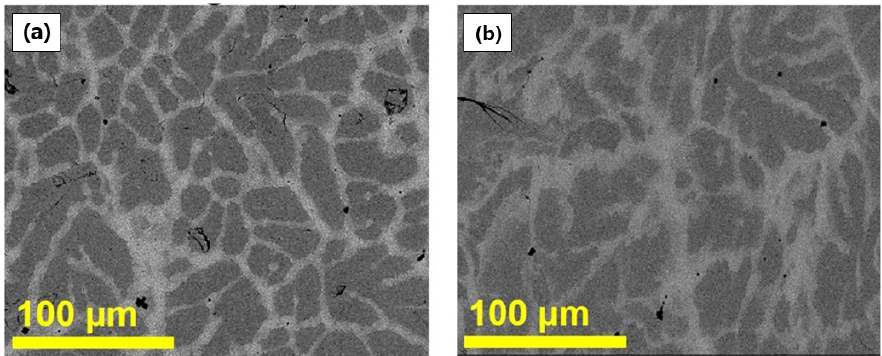
Figure 8. SEM images showing the microstructure of HEA TiAlFeCoNi ( a ) melted and ( b ) after processing by HPT (from [65]). Reprinted with permission from Elsevier: Mater. Sci. Eng., C. Copyright 2022, License: